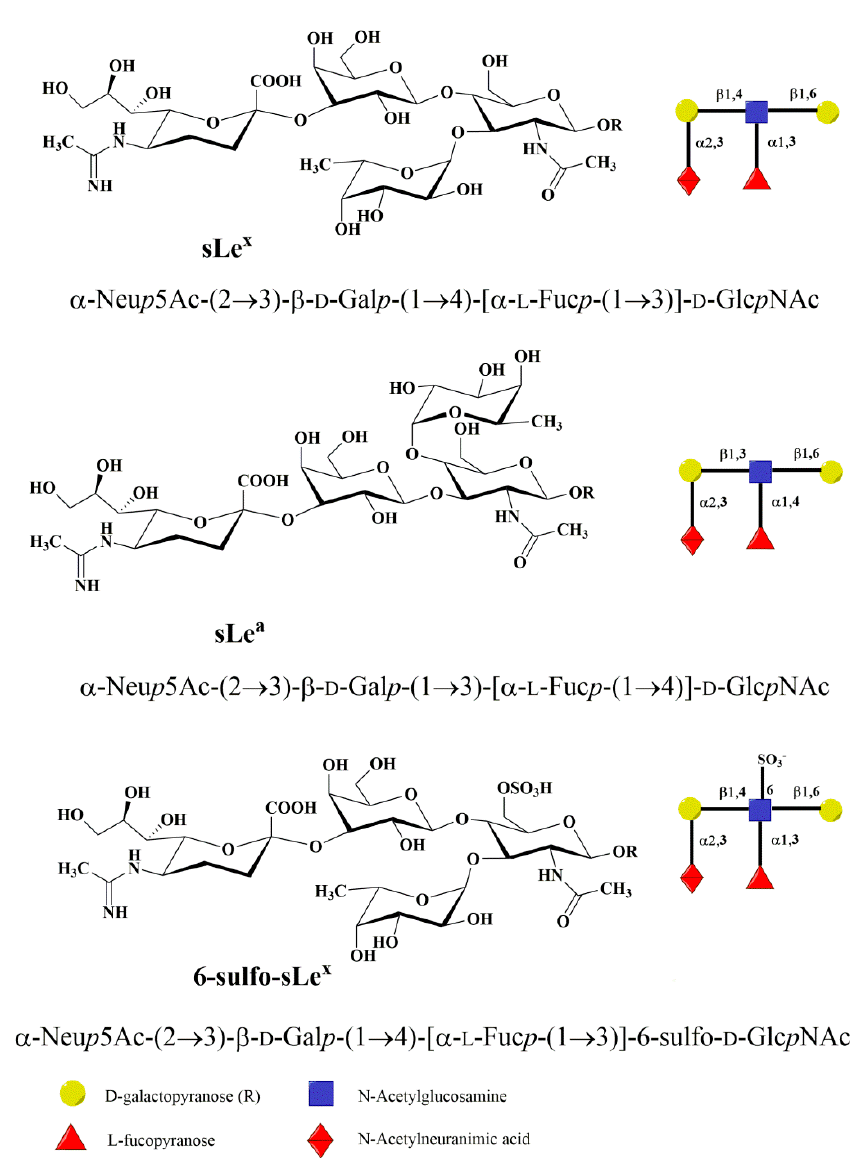
Figure 4. Schematic representation of minimal carbohydrate determinant structures-tetrasaccharides sLe x , sLe a , and 6-sulfo sLe x .